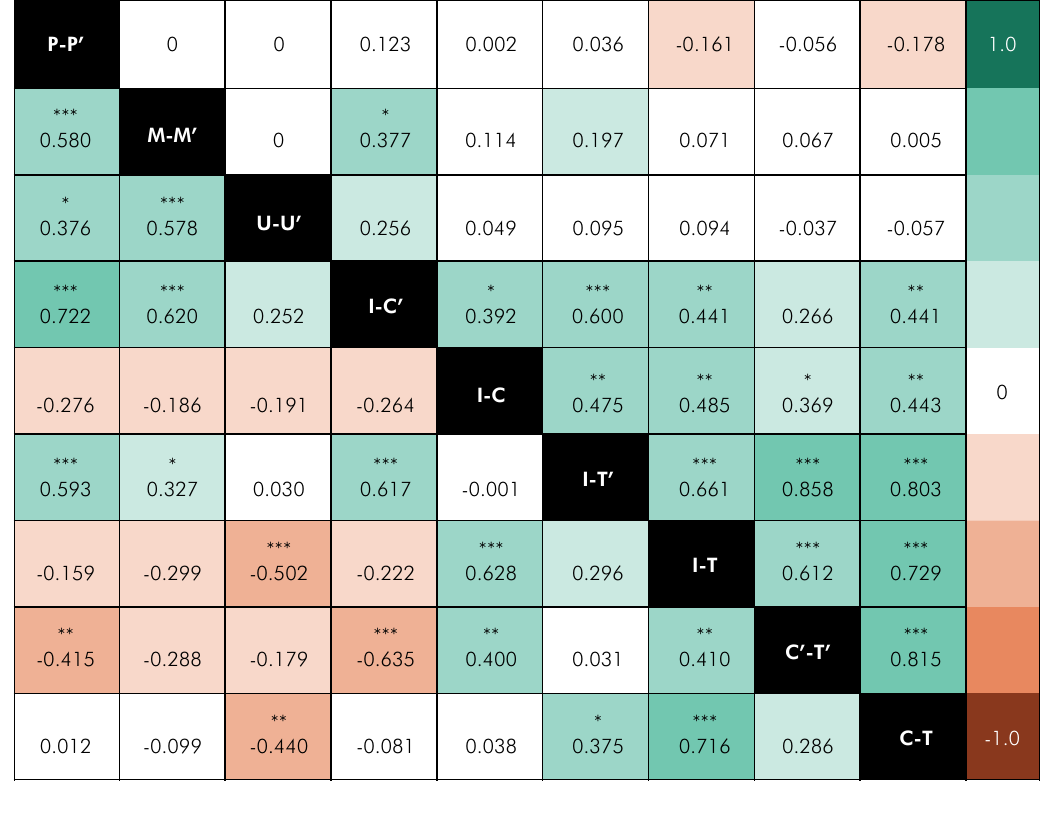
Figure 2. Pearson correlation matrix. The lower left-hand corner displays the coefficients at T1. The upper right-hand corner displays the coefficients at T2. The correlation matrix shows Pearson’s correlation values, which measure the degree of linear relationship between each measured parameter. The right column shows the color legend according to the coefficients, ranging from -1 (brown color) to +1 (dark-green color). Coefficients closer to -1 indicate inversely proportional parameters, while those closer to +1 indicate directly proportional parameters. Coefficients with a value of zero (white color) indicate a weak